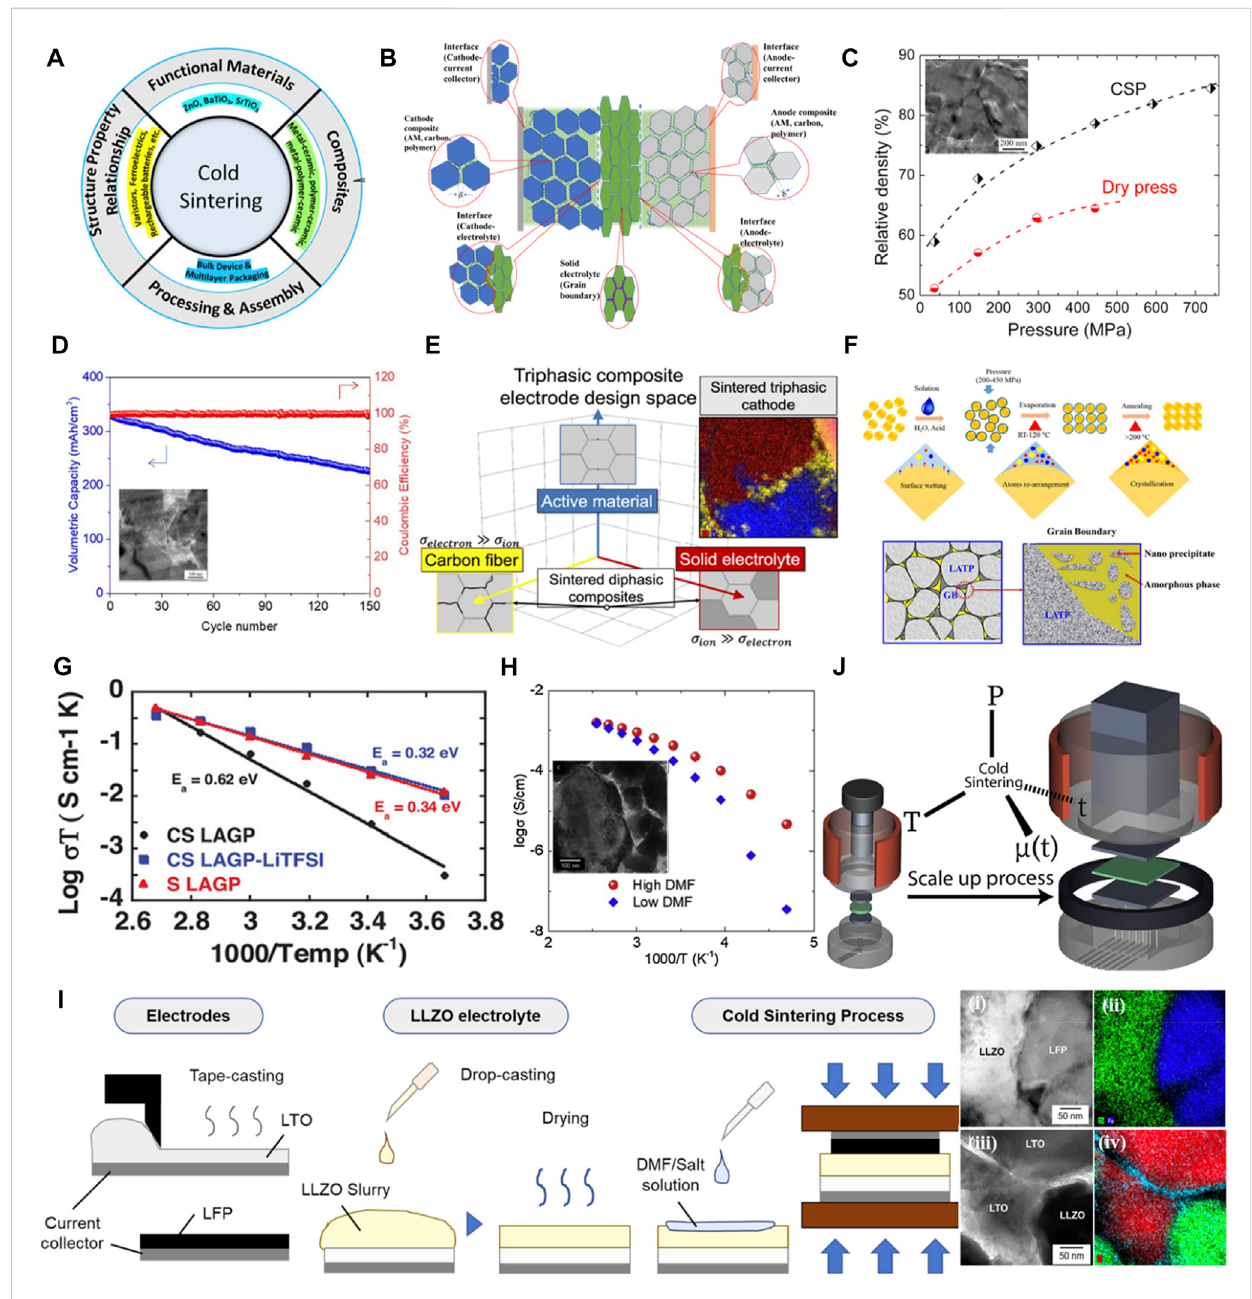
FIGURE 2 Cold sintering of composite electrodes, electrolytes, and multi-component layered-structure battery devices. (A) The process of CSP and its applications (Dursun et al., 2020). (B) The schematic of the CSP-assisted interface engineering for the integration of solid-state battery devices. (C) The pressure-dependent density of cold-sintered LiFePO 4 cathodes (Seo et al., 2017). Inset: an SEM image showing the morphology of the cold-sintered cathodes. (D) Thecharge-dischargecyclingperformanceofacold-sinteredLi 4 Ti 5 O 12 anode(Seoetal.,2019). (E) TheNASICONstructuredtriphasic composite electrode (Grady et al., 2021). (F) The CSP of the Li 1.3 Al 0.3 Ti 1.7 (PO 4 ) 3 (Liu et al., 2019). (G) The ionic conductivity of the cold-sintered LAGP- LiTFSI solid-state composite electrolyte (Lee et al., 2019). (H) The ionic conductivity of the cold-sintered LLZO-SM electrolyte. Insert: A TEM image showing the sintered particles (Seo et al., 2020). (I) The interface illustrations of the multi-component layered-structure solid-state battery device via STEM and elemental mappings (Seo et al., 2021). (J) The scale-up con fi guration of the cold sintering system (Bang et al., 2020b). All reproduced with permission,